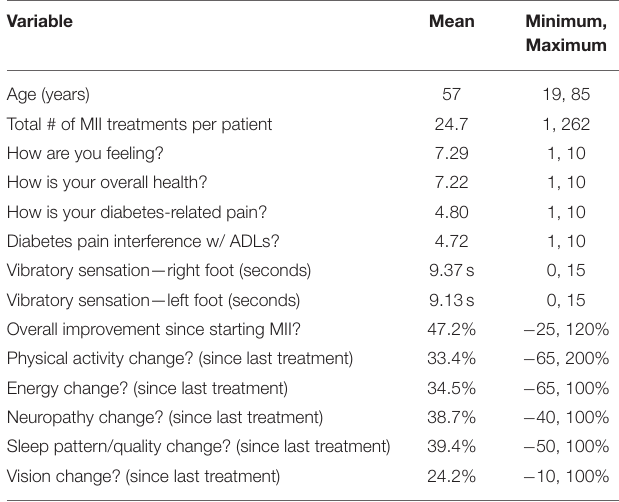
TABLE 3B | Descriptive statistics—self-report/subjective data (continuous